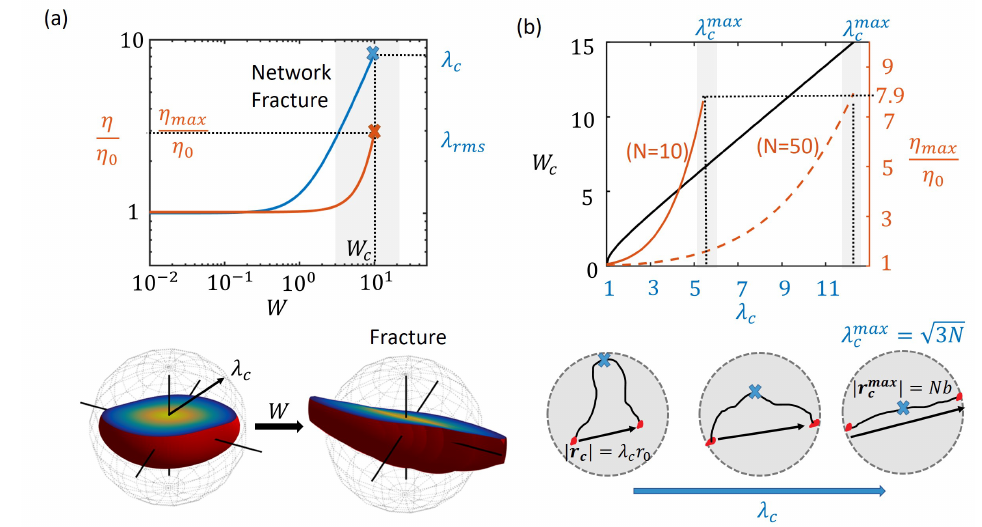
Figure 4. ( a ) the point of network fracture shown in a plot of viscosity η vs. Weissenberg number W when the average chain stretch equals the critical value, λ c , for N = 50. The distribution function is shown at steady state indicating most chains within the critical stretch at low shear rates (left) and leading to fracture at high shear rates (right); ( b ) the relationship between macroscopic entities such as maximum viscosity, η max / η 0 and the critical Weissenberg number, W c , and the critical chain stretch for fracture, λ c are plotted where the maximum value for the critical stretch ratio, λ max c corresponds to that of a fully extended chain ( r = Nb